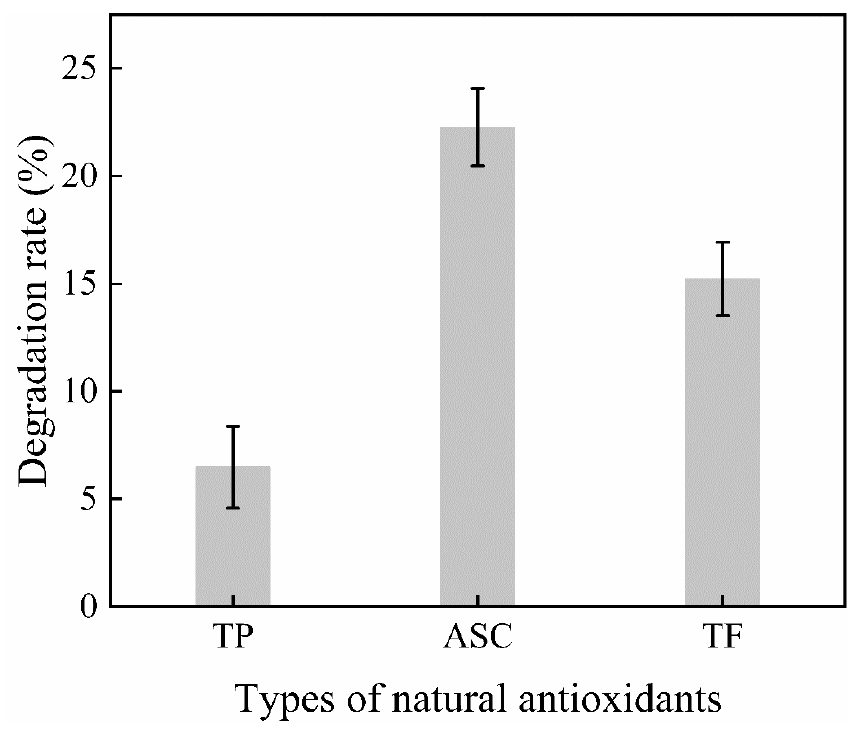
Figure 2. Effect of 1.0% natural antioxidant species on the citral degradation rate.